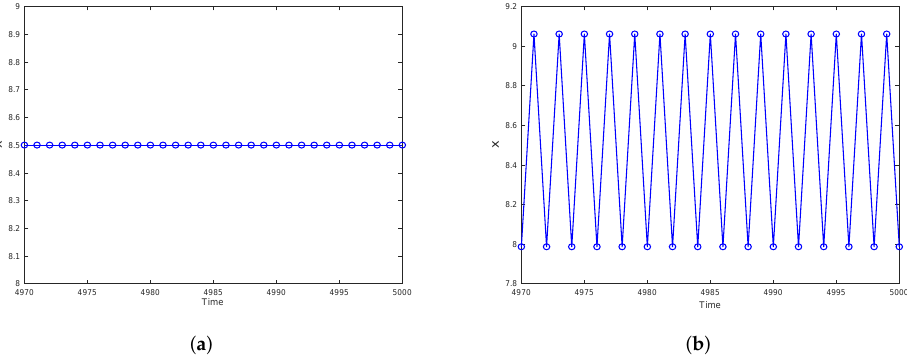
Figure 6. Time series of the first species for the controlled system (32) with different ρ . ( a ) ρ = 0.58; ( b ) ρ =